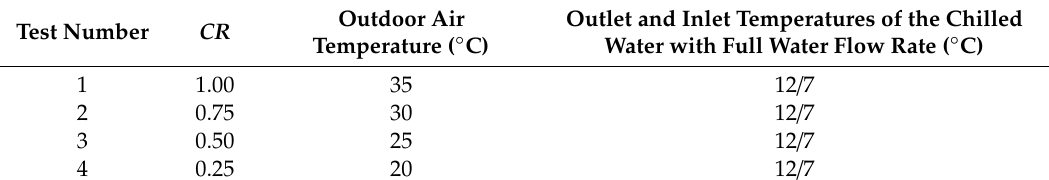
Table 1. Reference tests to determine the heat pump EER for different capacity ratio ( CR) values [38,45].